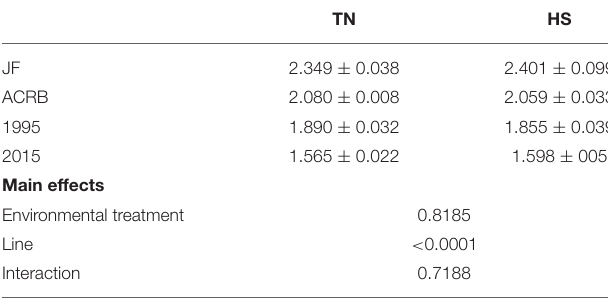
TABLE 2 | Effect of heat stress on the global feed conversion ratio (FCR through day